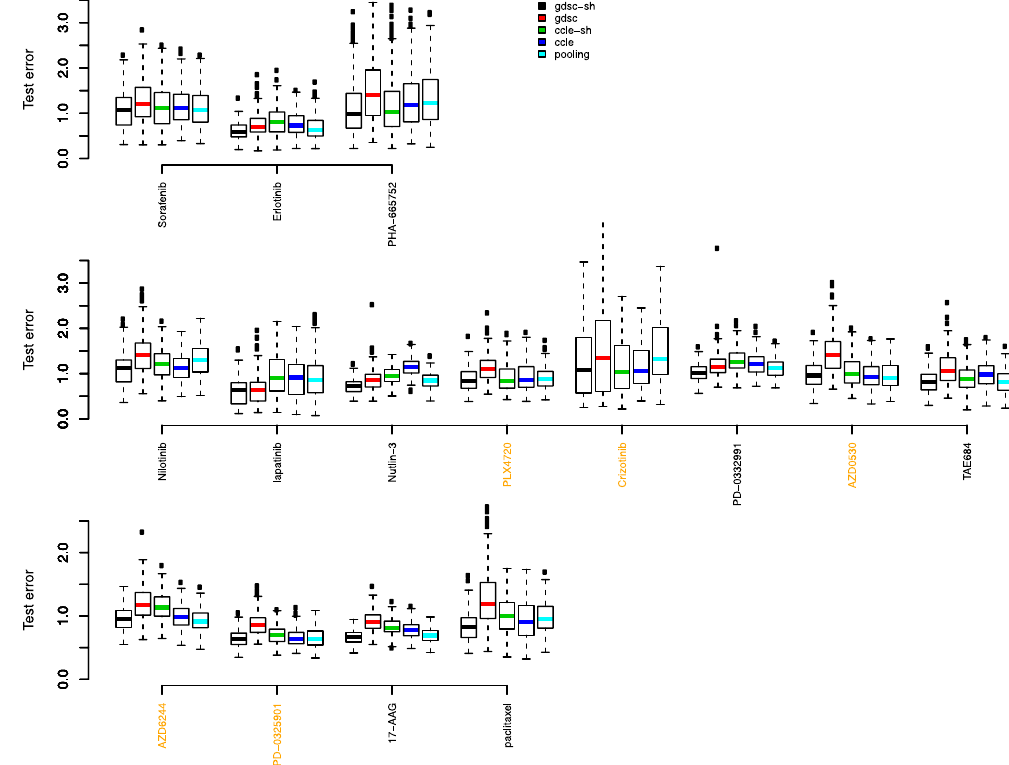
Figure 6. Test error rates by drug when 80% GDSC were used in training data and 20% GDSC dataset were reserved as test data. Black represents predictions based on data sharing estimates for β alone; red for predictions from a model using GDSC alone; green for predictions from a data sharing model using estimates of β + δ ; blue for predictions from a model using CCLE alone, and light blue, predictions from a pooled GDSC + CCLE model.